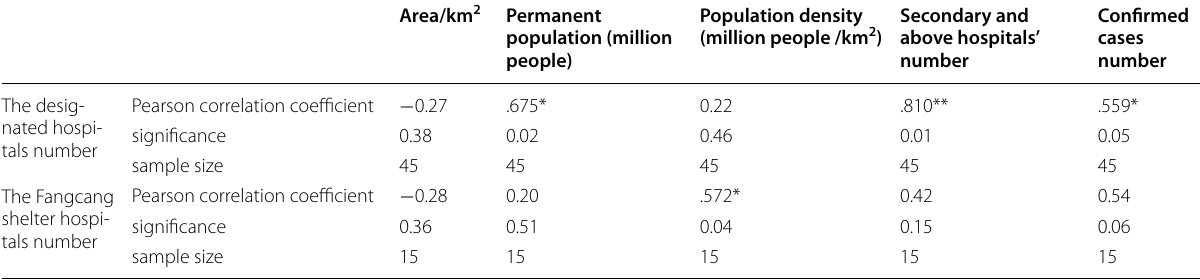
Table 3 Pearson correlation coefficient